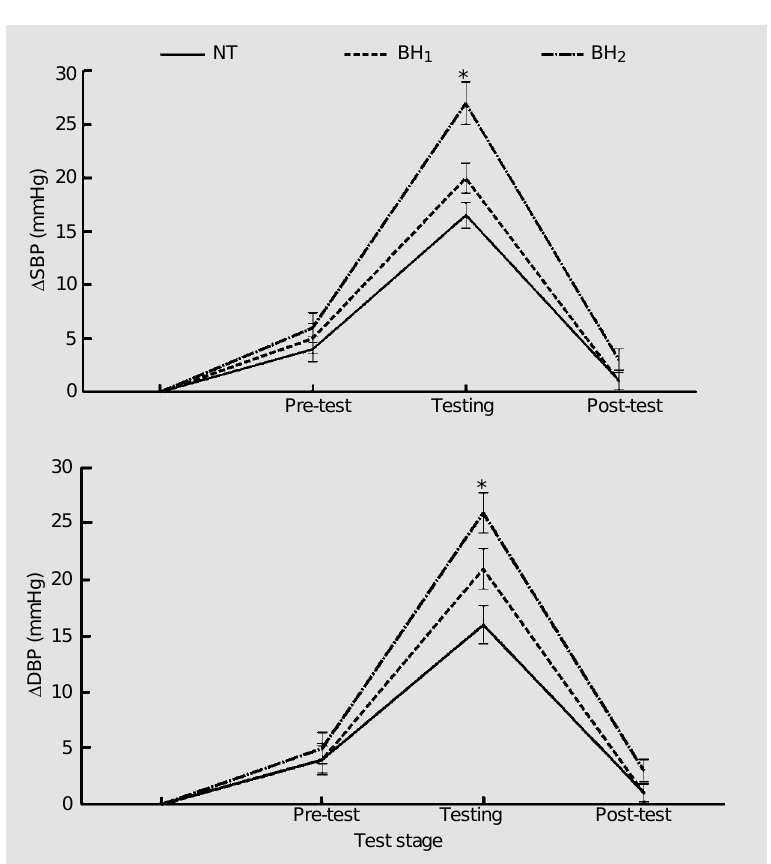
Figure 2. Cold pressor test. Change in systolic blood pressure ( D SBP) and diastolic blood pressure ( D DBP) recorded for the normotensive (NT), borderline hypertensive with normal (BH 1 ) and elevated (BH 2 ) monitored blood pressure levels in the pre-test, testing and post- test periods. Values are reported as means ± SD. *P<0.05, BH 2 compared to NT and BH 1